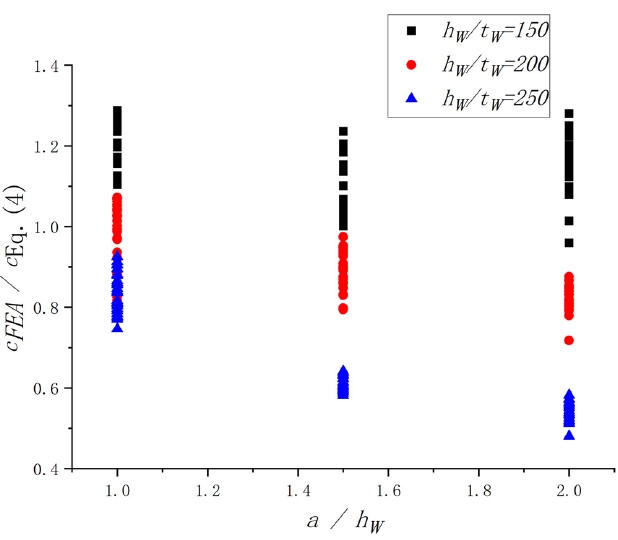
Figure 20. Influence of the a / h w on the c FEA / c Eq.(4) .